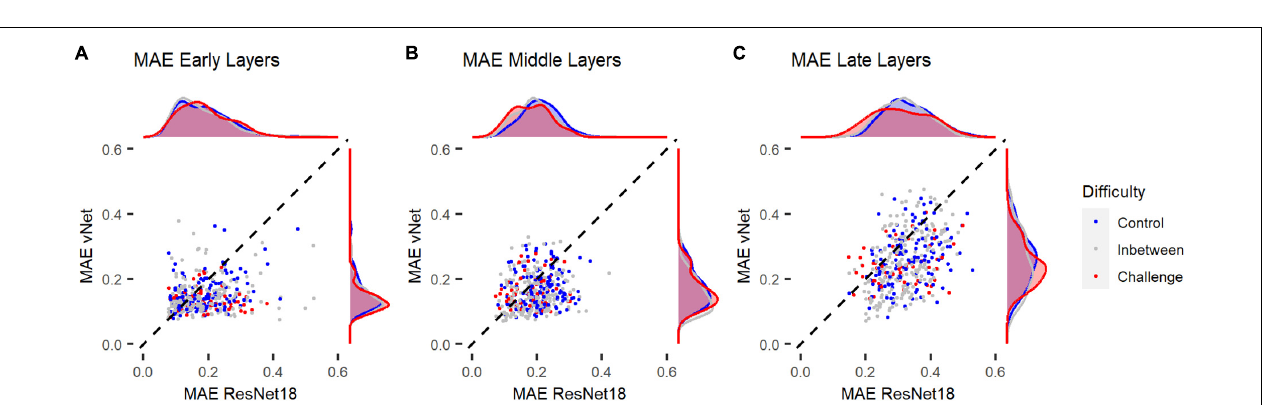
FIGURE 8 | Examples of human observer heatmaps and DCNN GradCAMs of different layers. Images with (A) the highest and (B) the lowest correlation between human observers and ResNet18. Images with (C) the highest and (D) the lowest correlation between human observers and vNet. Images highlighted in green were categorized correctly while images highlighted in red were categorized incorrectly.